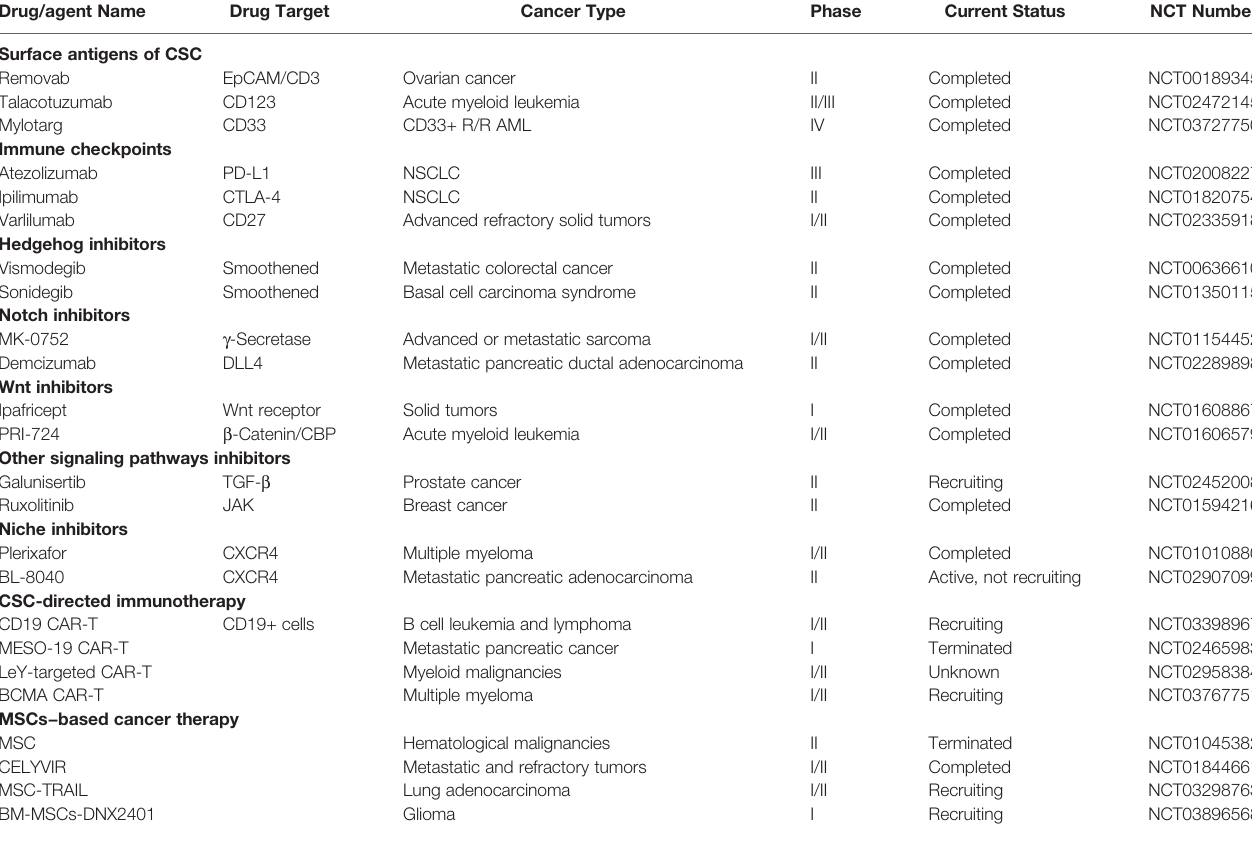
TABLE 2 | Agents targeting CSC, MSC, and CSC-MSC crosstalk in clinical trials.